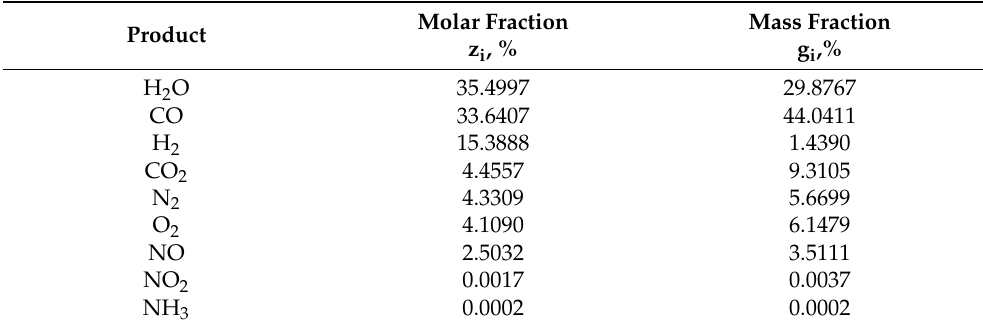
Table 4. Chemical composition of gaseous products determined using the TIGER thermodynamic code from the balance of chemical equilibrium of detonation combustion of a mixture with the composition presented in Table 2.